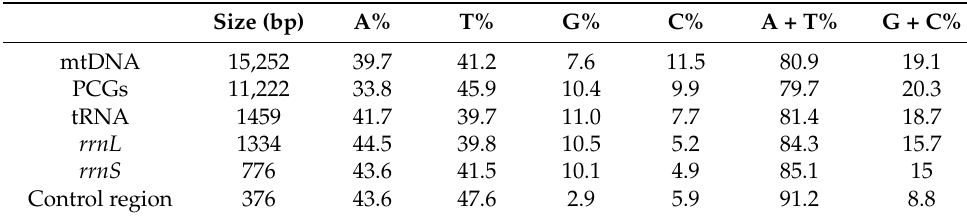
Table 3. Base composition of Hestina persimilis mitogenome.